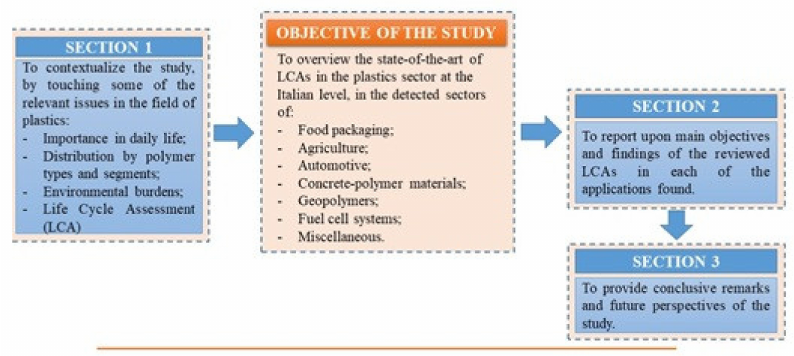
Figure 3. Review’s